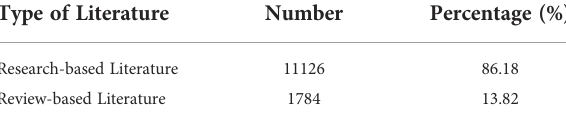
TABLE 1 Distribution of literature